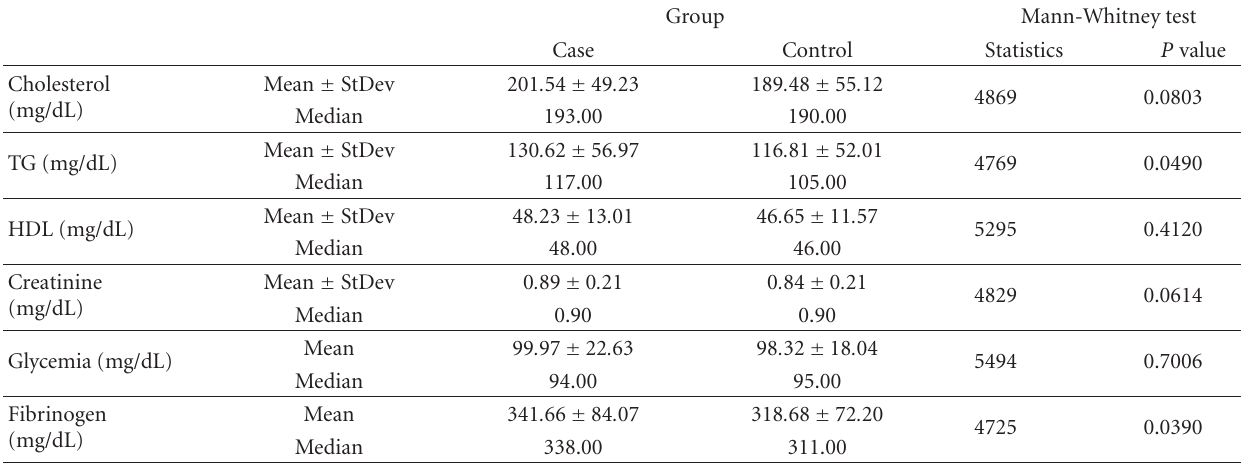
Table 2: Biochemical data for PAOD patients and controls.